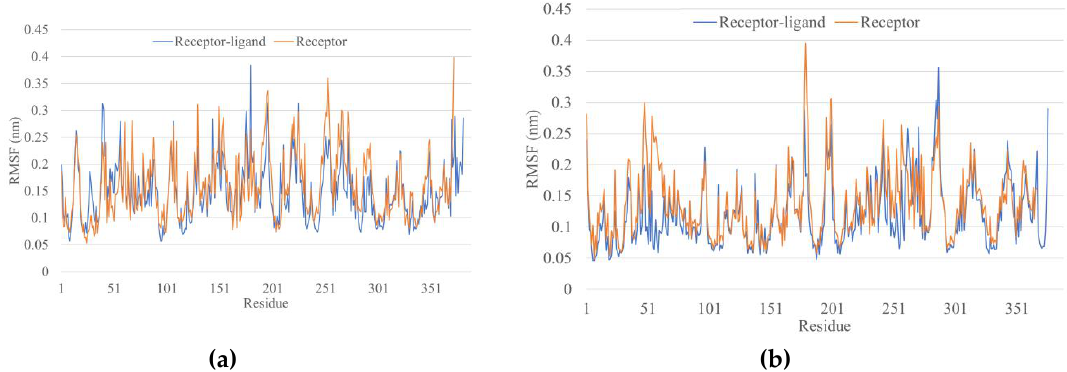
Figure 3. Residual RMSF after 20 ns simulation. ( a ) Epitope WFHDIPLPW with HLA-C*04:01; ( b ) epitope WAIYAALTT with HLA-DRB1*15:02.